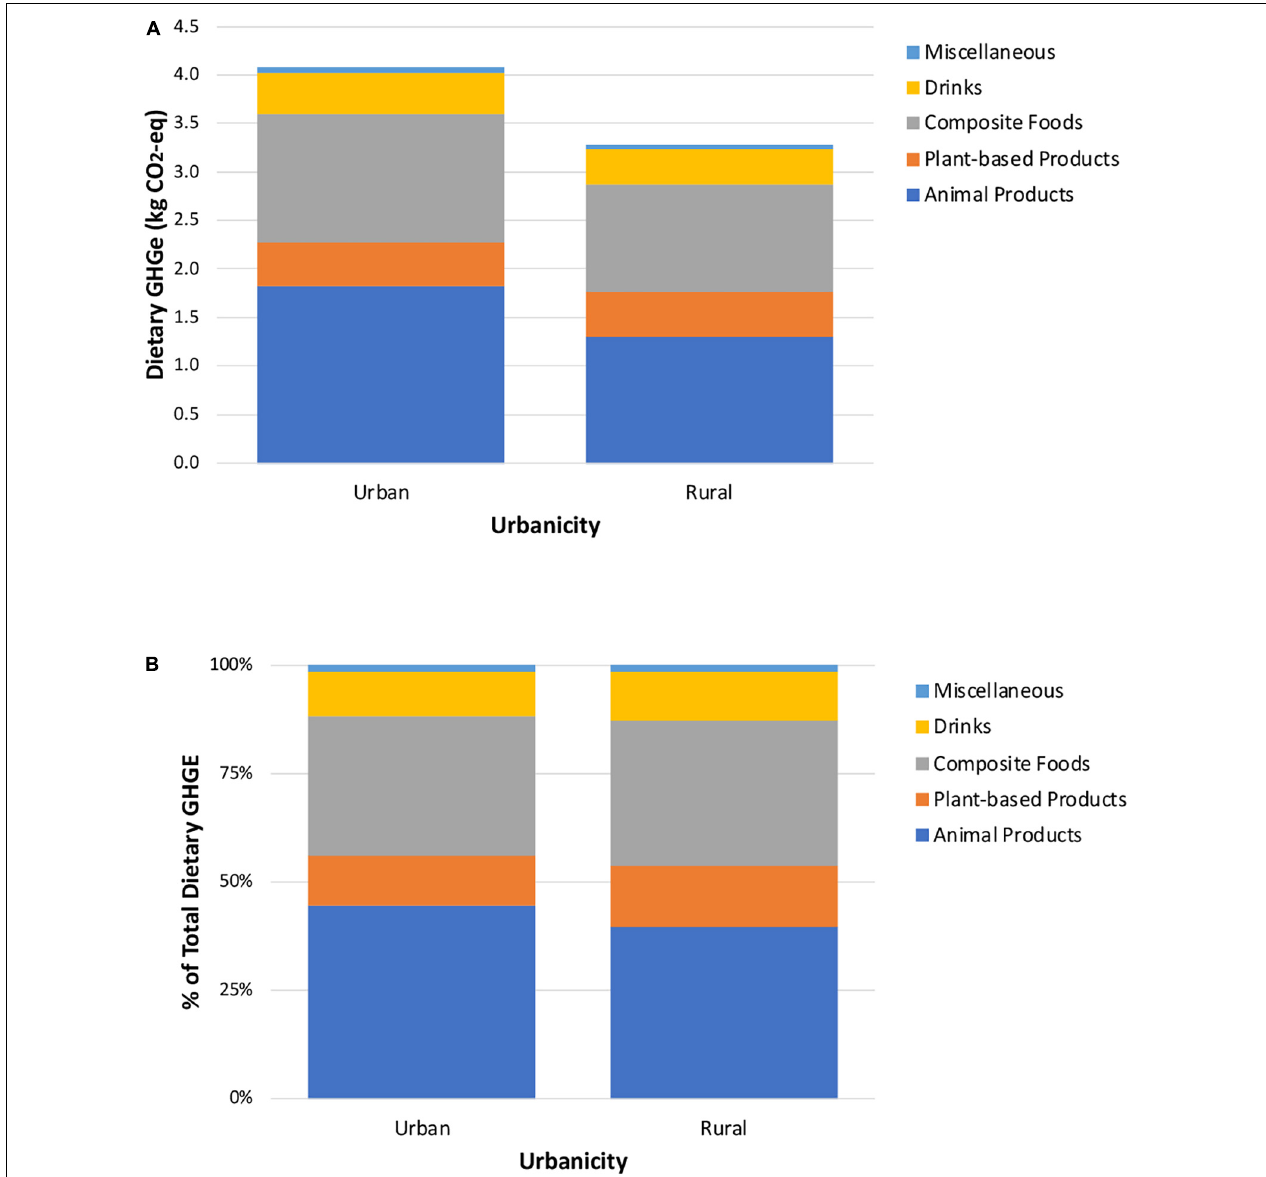
FIGURE 3 | Absolute (A) and relative (B) contribution of each aggregated food and beverage group to total dietary greenhouse gas emissions, stratified by